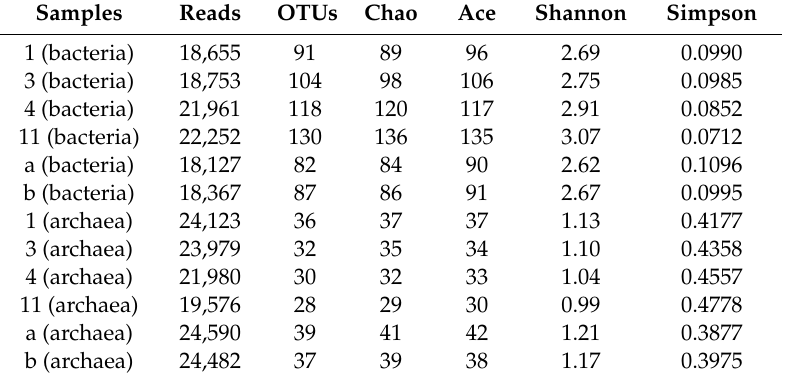
Table 2. Sequencing results of bacterial and archaeal community abundance and diversity indices from the six samples.